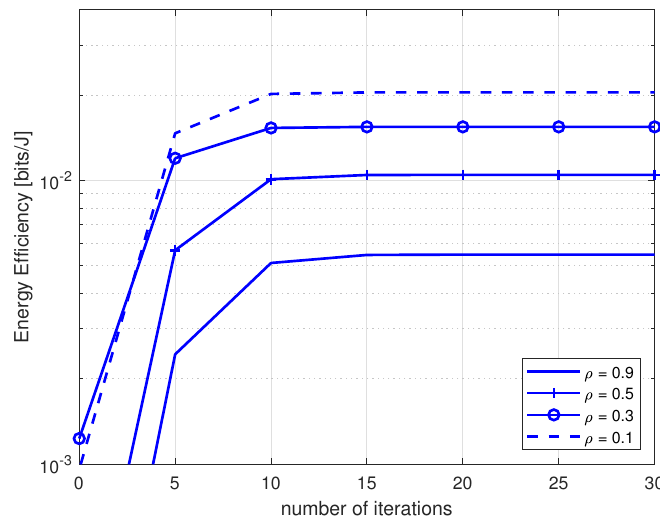
Figure 8. EE at 20 dB versus different power splitting ratio.